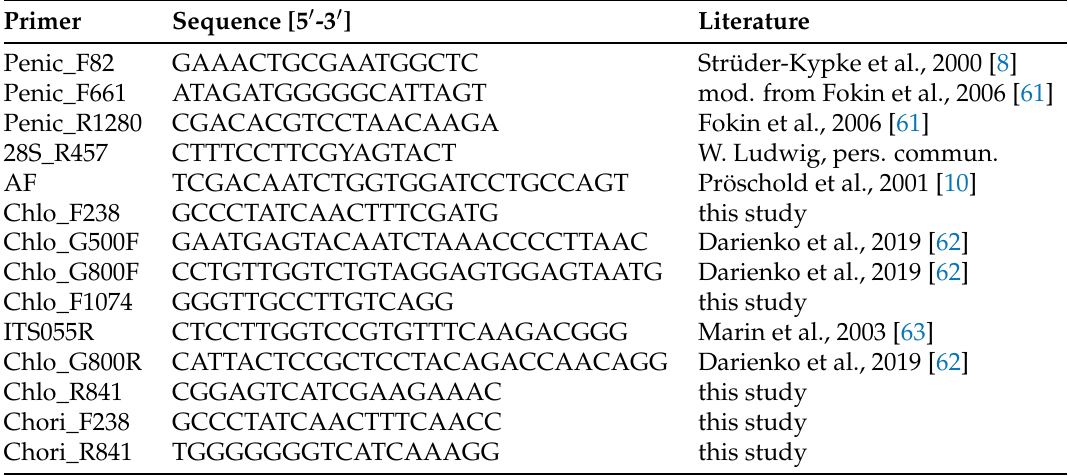
Table 2. Oligonucleotides used for molecular characterization of both P. bursaria and symbiotic